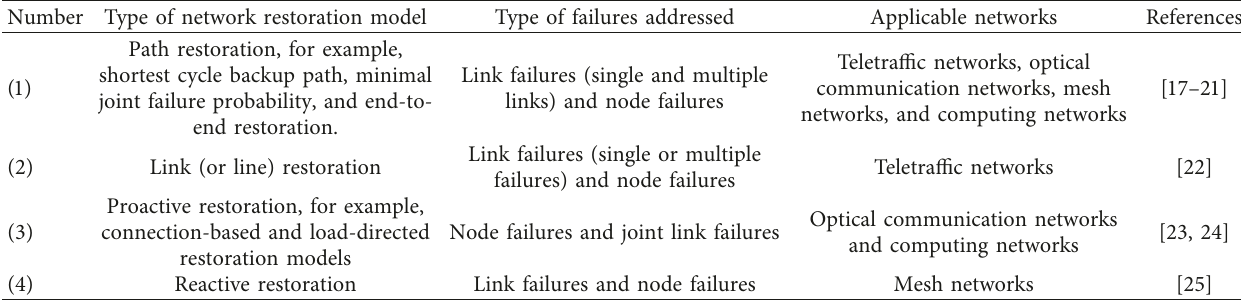
Table 1: Summary of network restoration models employed in current communication and computing